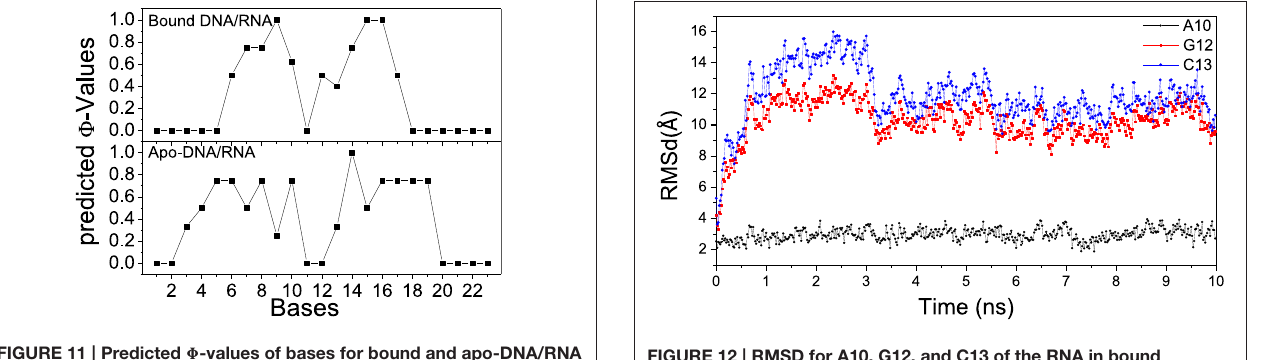
FIGURE 12 | RMSD for A10, G12, and C13 of the RNA in bound mismatch